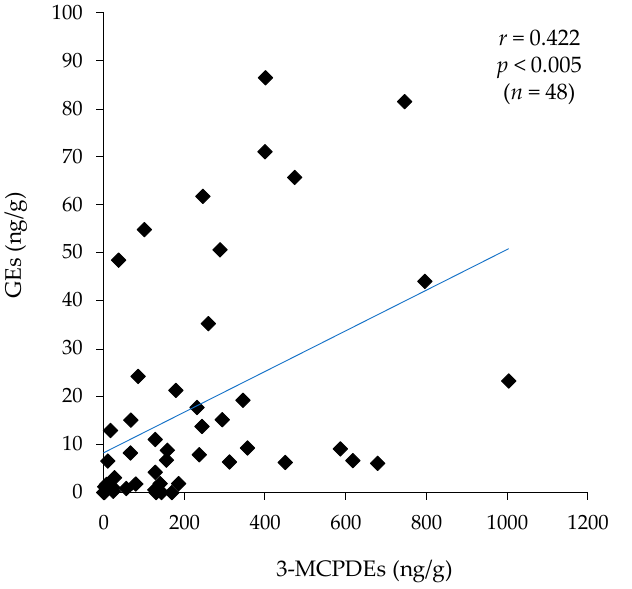
Figure 2. Plot of the amounts of GEs and 3-MCPDEs in individual food products.